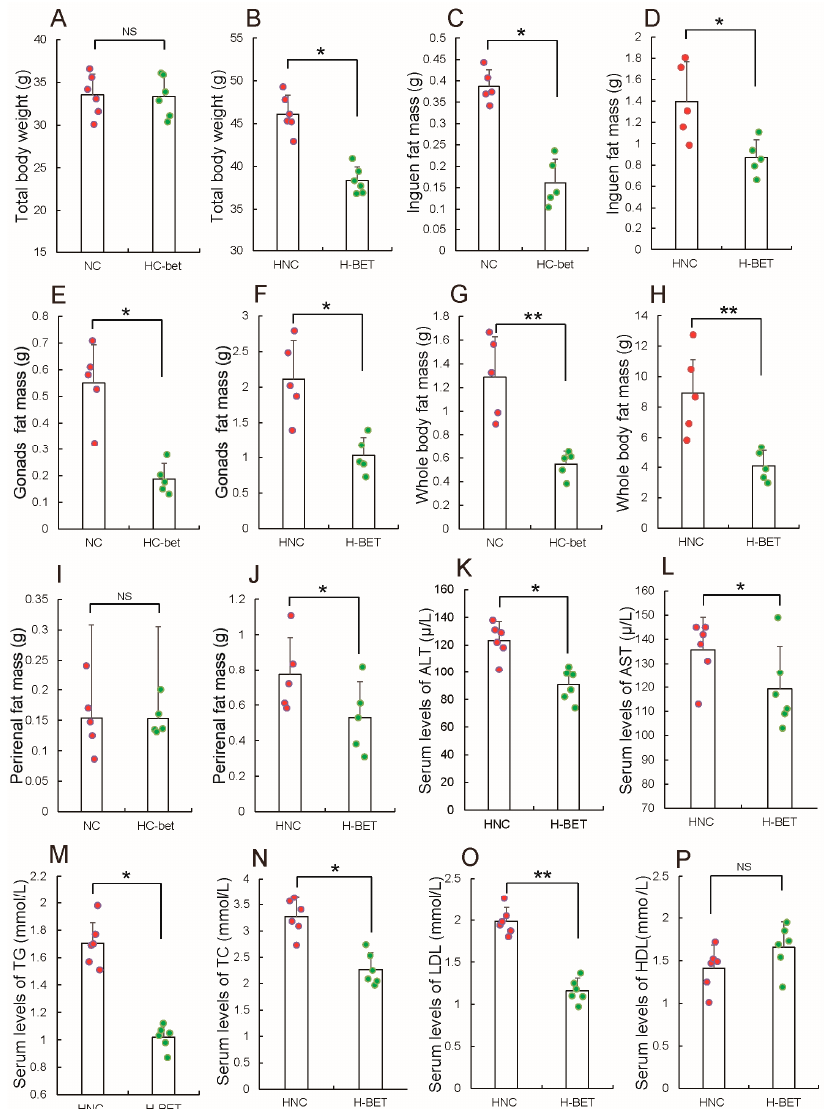
Figure 2. Betaine supplementation limits high-fat diet (HFD)-induced obesity. Following mice fed with HFD or NCW, treated with or without 1% betaine in water, ( A , B ) body weight in normal chow (NCW)-fed mice treated without (NC) or with (HC-bet) betaine, HFD feeding mice treated without (HNC) or with (H-BET) betaine were measured. Then, ( C , D ) inguen fat mass; ( E , F ) gonads fat mass; ( G , H ) whole body fat mass and ( I , J ) perirenal fat mass in NC or BET were measured. Additionally, after HFD-fed and NCW-fed mice were treated with or without 1% betaine in water, serum levels of ( K ) alanine transaminase (ALT); ( L ) aspartate aminotransferase (AST); ( M ) triglycerides (TG); ( N ) cholesterol (TC); ( O ) low-density lipoprotein (LDL); ( P ) high-density lipoprotein (HDL) were tested. All results are presented as means ± standard error (SE). n = 6. * p < 0.05; ** p < 0.01; NS, no